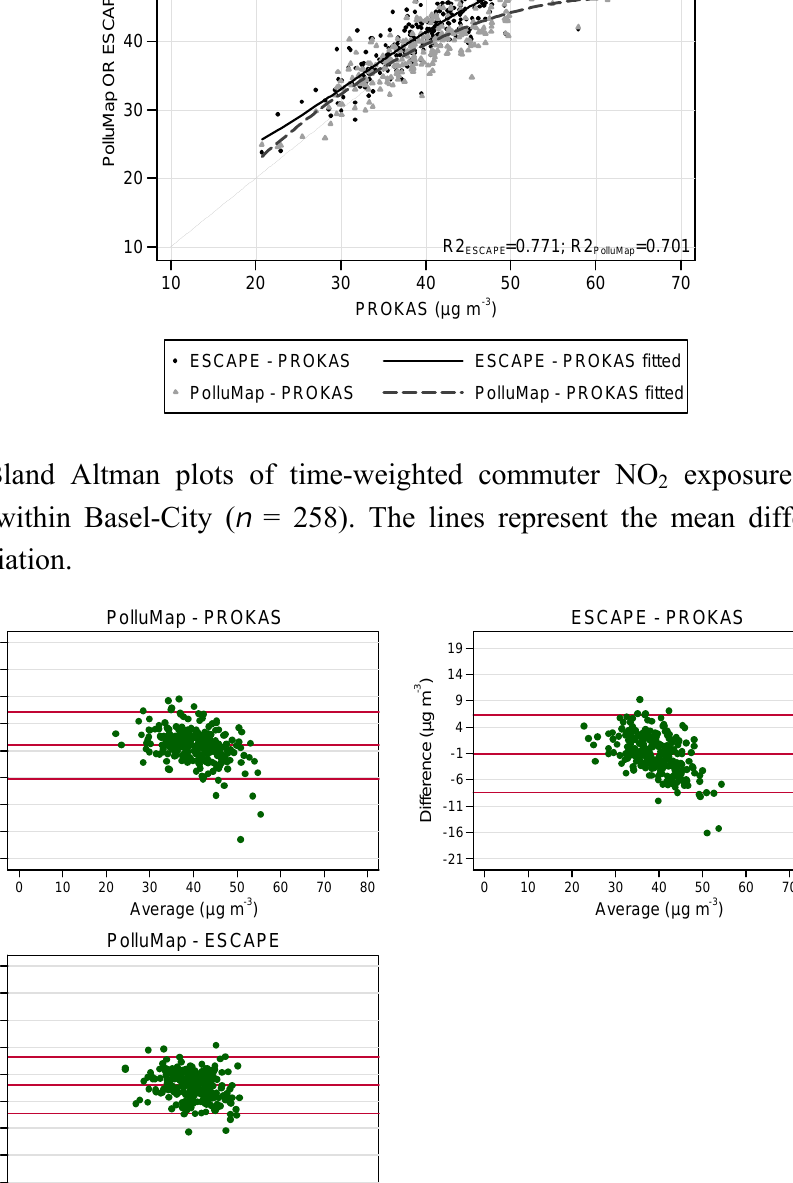
Figure 3. Scatter plot comparing subjects’ estimated commuter NO on the high spatial resolution model (PROKAS) with the estimates from PolluMap and ESCAPE models, respectively, using subjects from Basel-City ( n = 258).